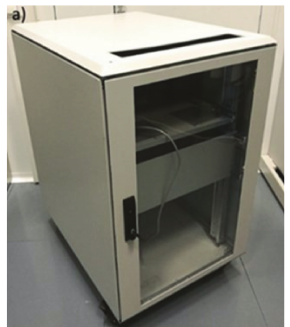
Fig. 5. New sampling line for use with 14 C CRDS